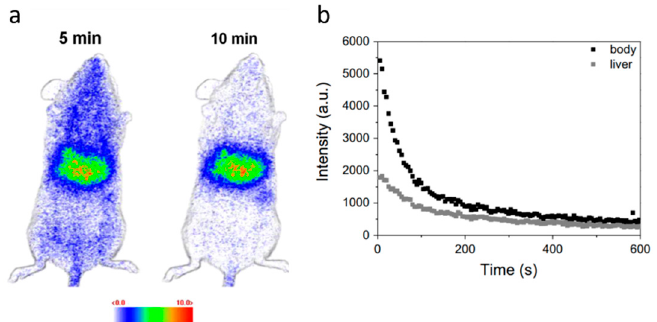
Figure 14. ( a ) In vivo imaging obtained at 5 and 10 min after the injection of the PeL-NPs. ( b ) Emission intensity as a function of the time monitoring the whole body and liver during the first 10 min of experiment. Pel-NPs: HAp / β -TCP doped Eu 2 + / Eu 3 + , Mn 2 + and Dy 3 + . [PeL-NPs] = 0.8 mg / 200 µ L glucose. Reproduced from [245] with permission from Elsevier.